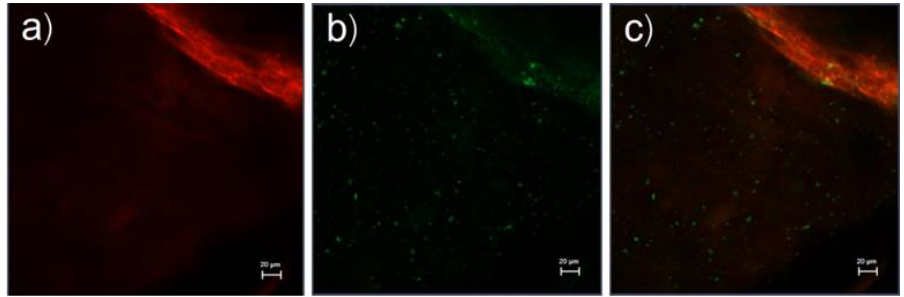
Figure 5. ( a ) Red fluorescence, ( b ) green fluorescence, and ( c ) merged image at the 55 µm layer in Figure 4a. The scale bar represents 20 μm.